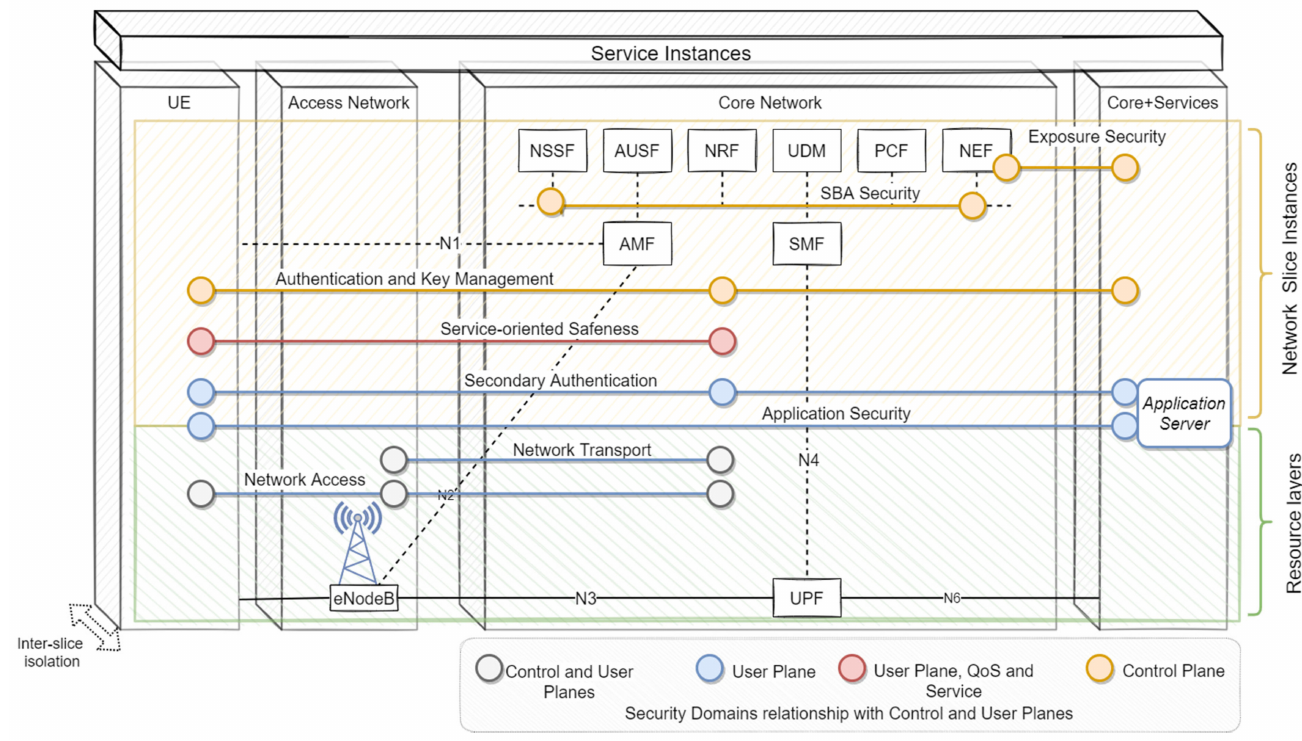
Figure 8. Security domains of 5G